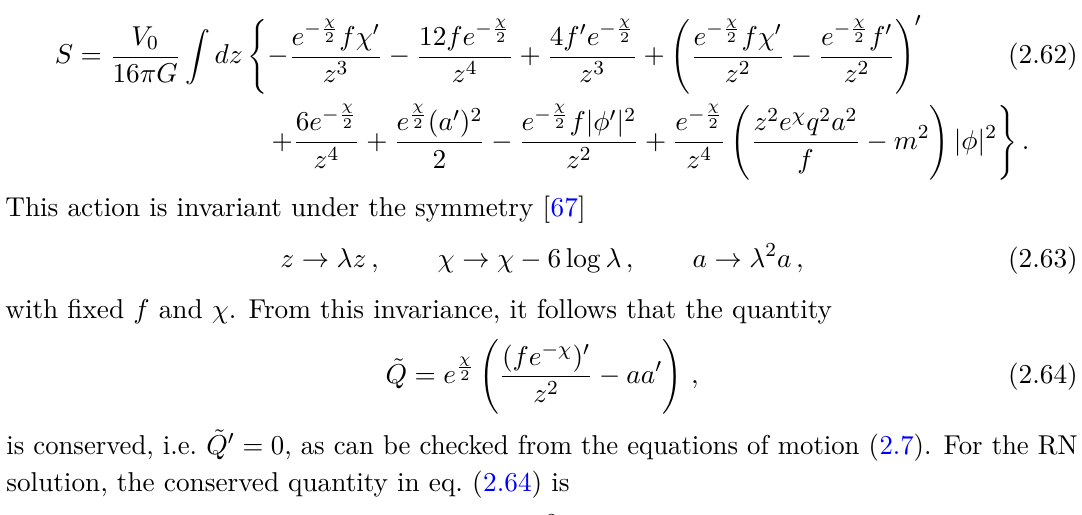
JHEP08(2022)235